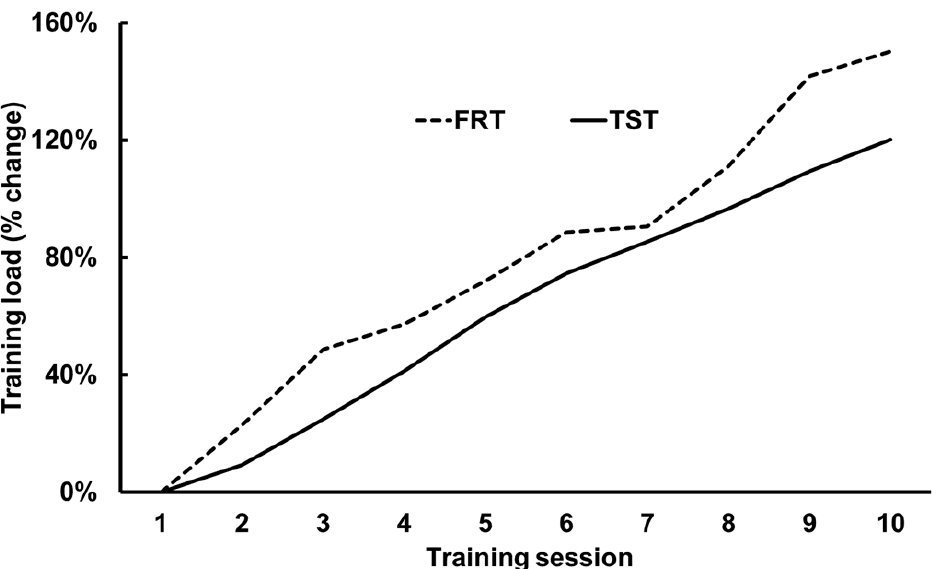
Figure 3. Change in average peak power produced (W) and weights (kg) lifted during the first 10 resistance training sessions with FRT or TST.